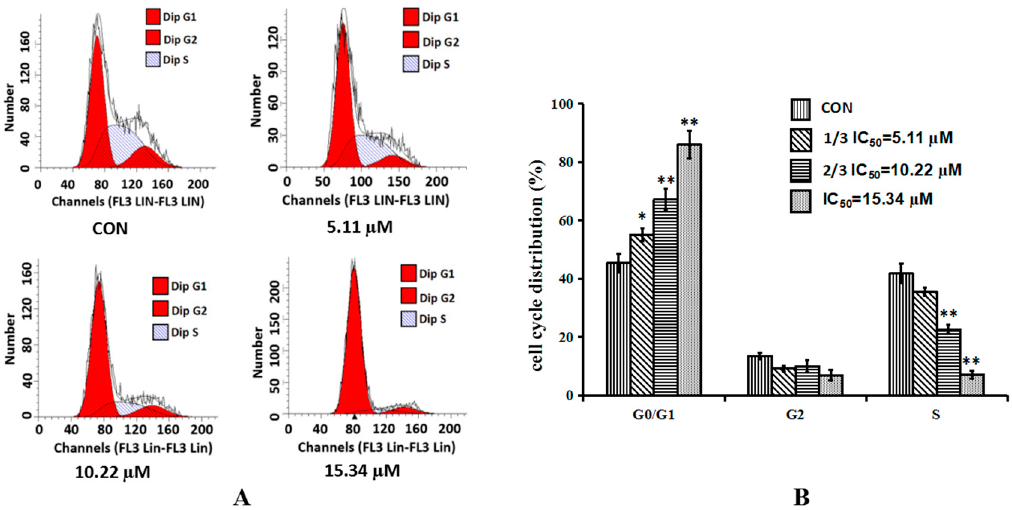
Figure 3. Effects of cordycepin on the cell cycle of H1975 cells in vitro. ( A ) H1975 cells were treated with cordycepin at 5.11 µM, 10.22 µM and 15.34 µM for 48 h and the DNA content was analyzed by flow cytometry; ( B ) Histogram summarized the results of ( A ). Cell numbers at G 0 /G 1 , G 2 and S phases were counted and the percentage was calculated. Error bars represent means ± SEM of n = 3. * p < 0.05 and ** p < 0.01 vs. control group.